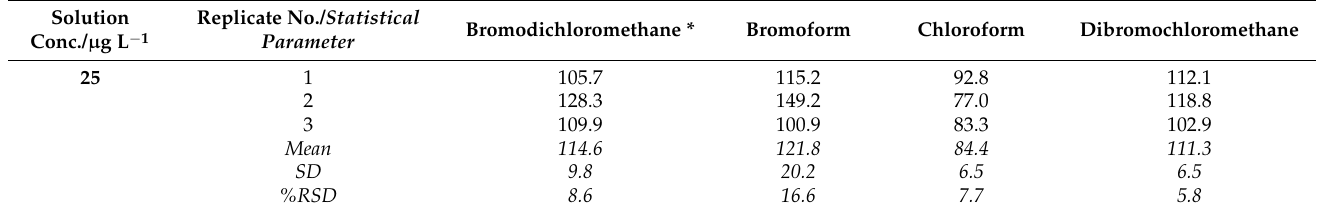
Table 12. Recovery data (%) for each of the triplicate measurements of 25, 50, and 75 µ g L − 1 THMs spikes in drinking water (Cambridge, UK) averaged across quantitation ions. Mean recovery, standard deviation (SD), and RSD are also